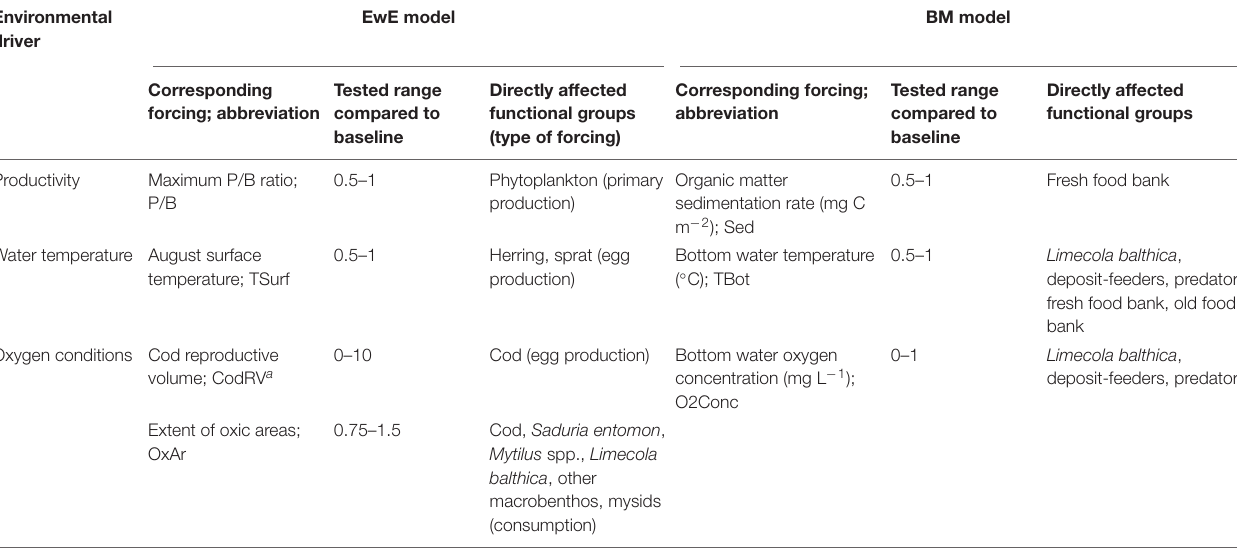
TABLE 1 | Studied environmental drivers, corresponding forcing, and functional groups directly affected by the forcing in the two